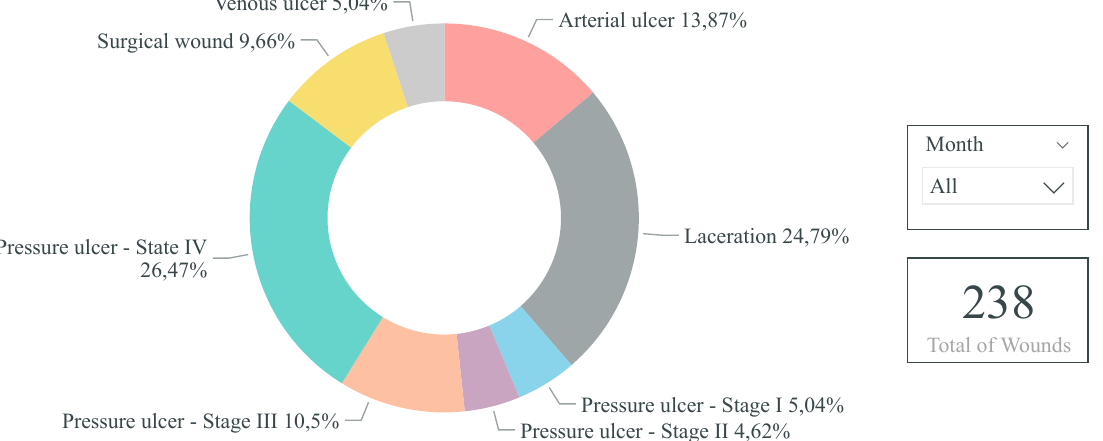
Figure 6. Indicator of the percentage of wounds per wound type (created with fictitious